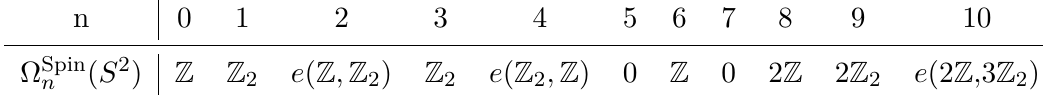
Table 6 . Cobordism groups Ω Spin